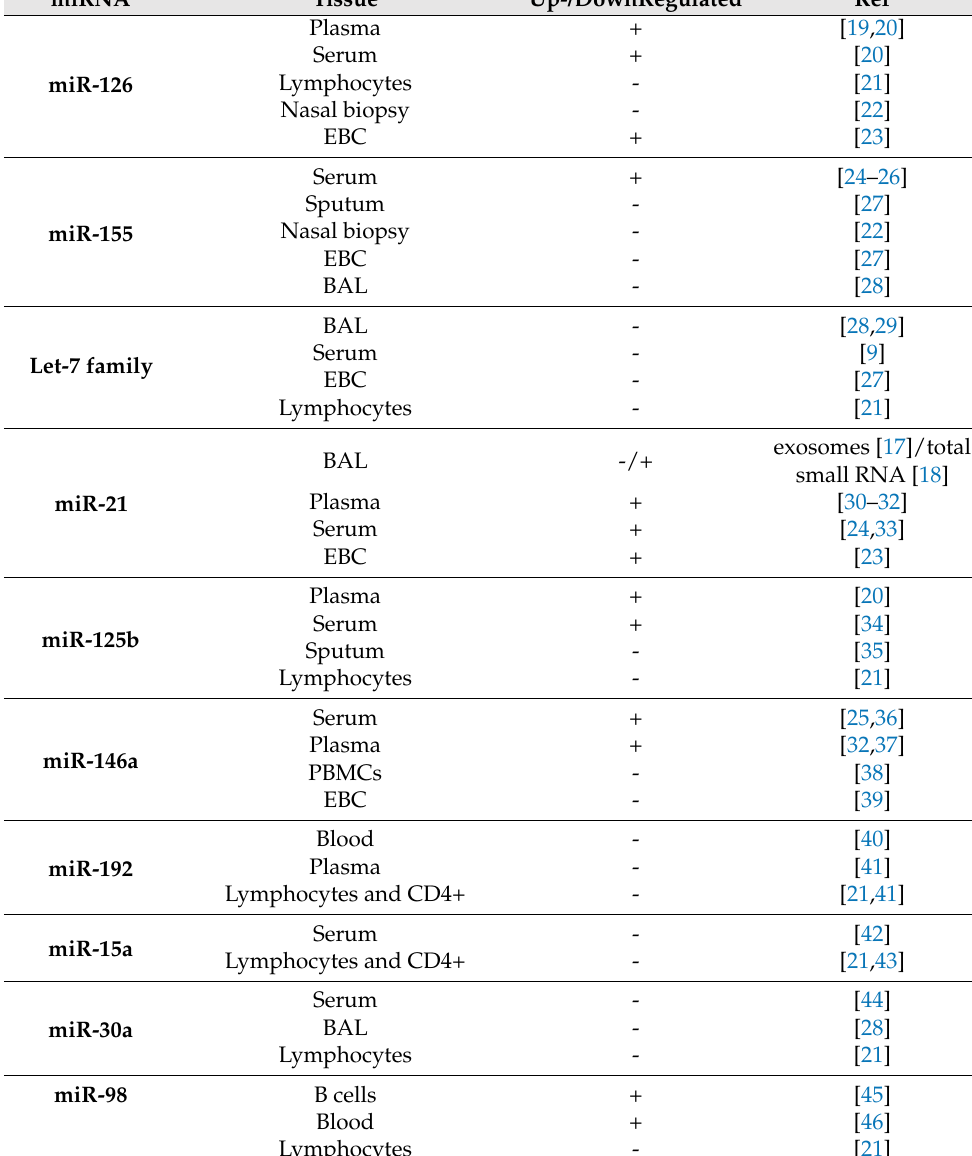
Table 1. miRNAs studied in more than two publications to be of diagnostic